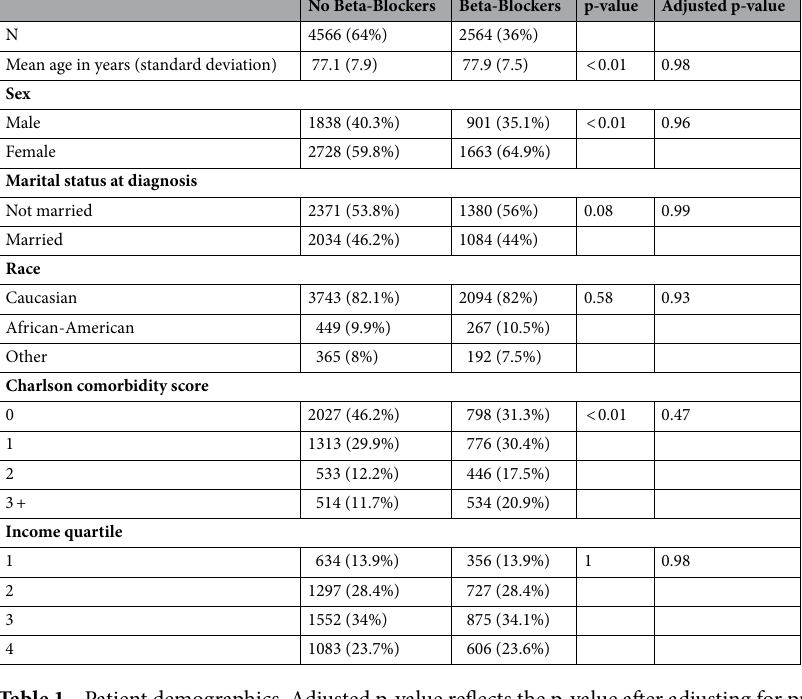
Table 1. Patient demographics. Adjusted p-value reflects the p-value after adjusting for propensity score for beta-blockers 6 months after diagnosis. Percentages or standard deviations are expressed in parentheses.